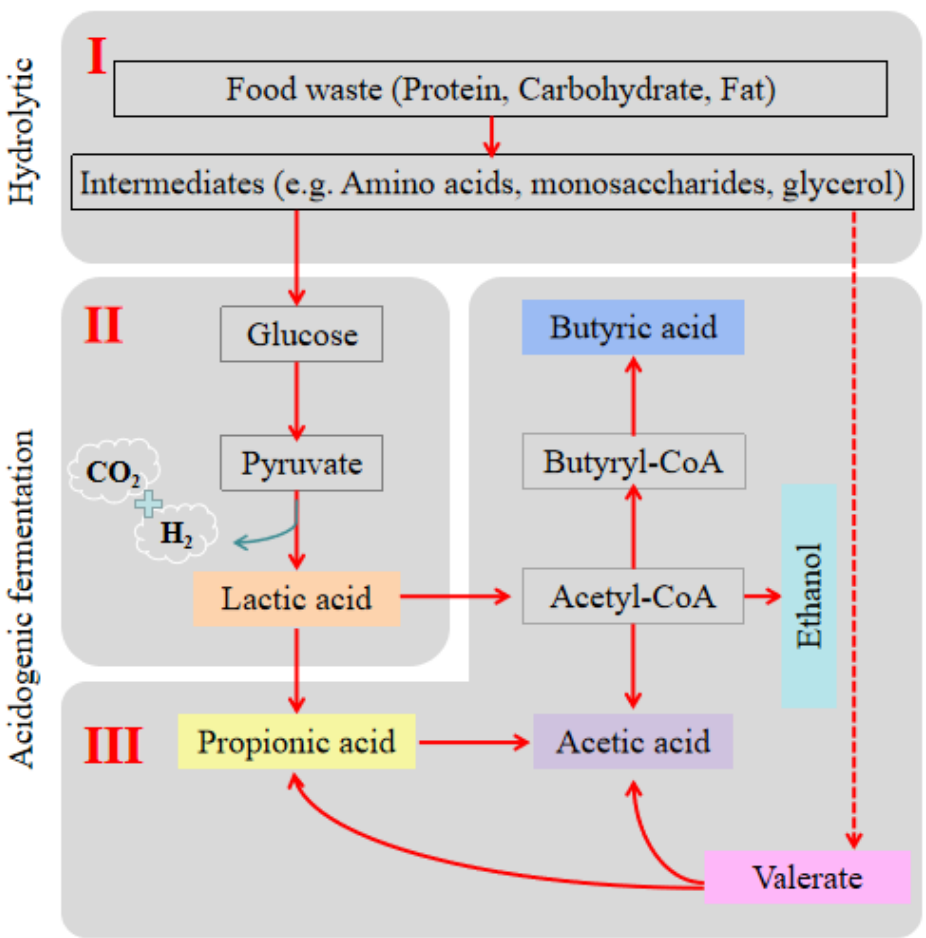
Figure 4. Proposed metabolic pathways for soluble product production in treatments with oil addition. the highest accumulation of lactic acid was observed in T4 (359.7 ± 14.26a), followed by T1 (318.3 ± 13.76b), T2 (305.3 ± 14.80b), CK (282.1 ± 7.66c), T3 (268.6 ± 9.11c), and